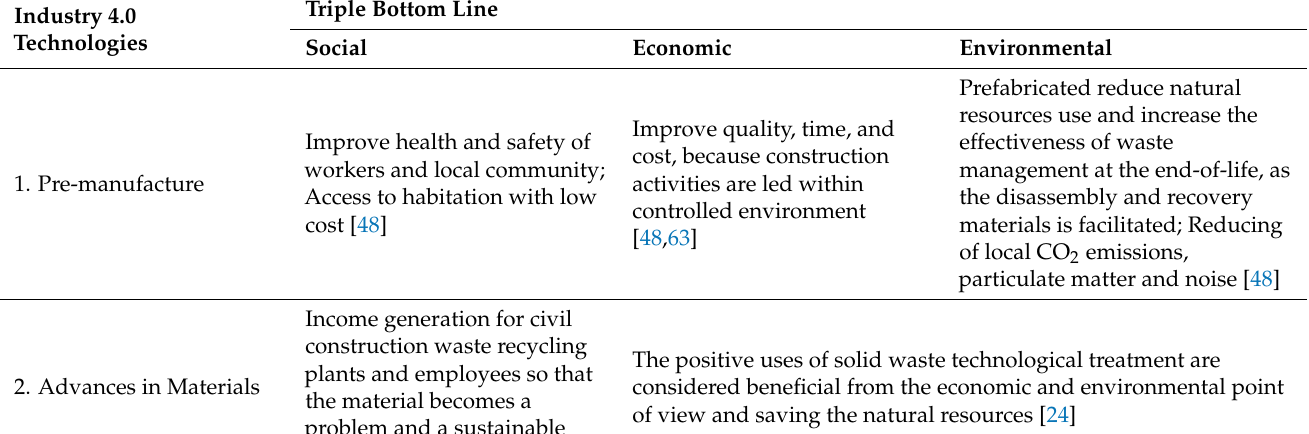
Table 4. Industry 4.0 Technologies Impacts to the Triple Bottom Line. Source: elaborated by the